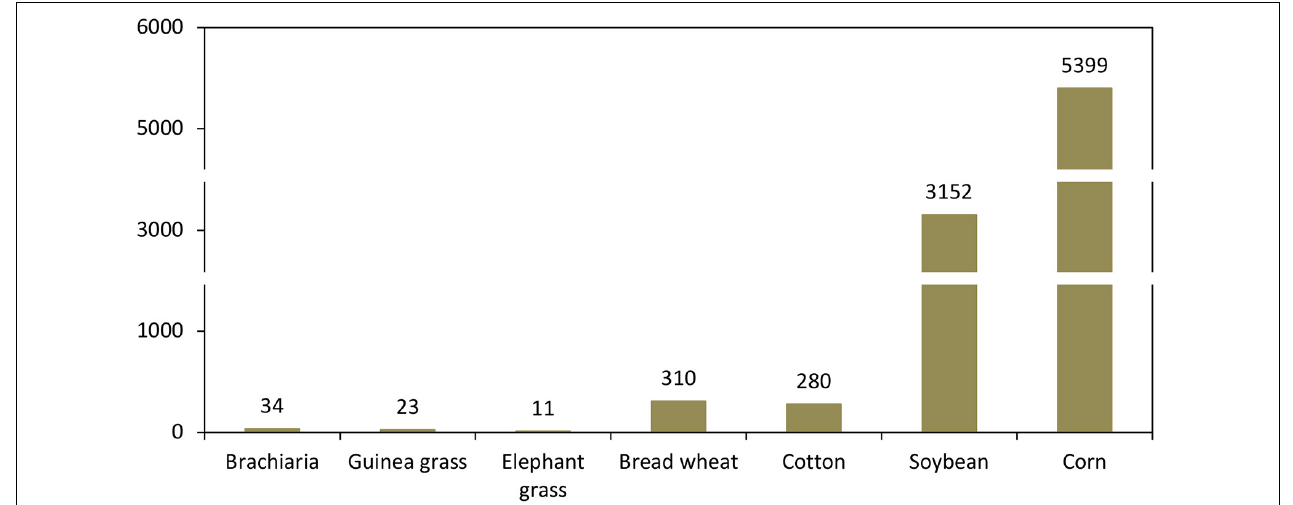
FIGURE 1 | Number of cultivars of brachiaria, Guinea grass, and elephant grass registered in Brazil in comparison with grain and fiber crops. The list was obtained from the National Cultivar Registry Data Bank ( Registro Nacional de Cultivares – RNC ) that is a requirement from the Brazilian Ministry of Agriculture, Livestock and Food Supply since 1997. The numbers shown here were retrieved on 19 November 2020 (http://sistemas.agricultura.gov.br/snpc/cultivarweb/cultivares_registradas. php). Because the difference in the number of cultivars is high, the Y-axis has been